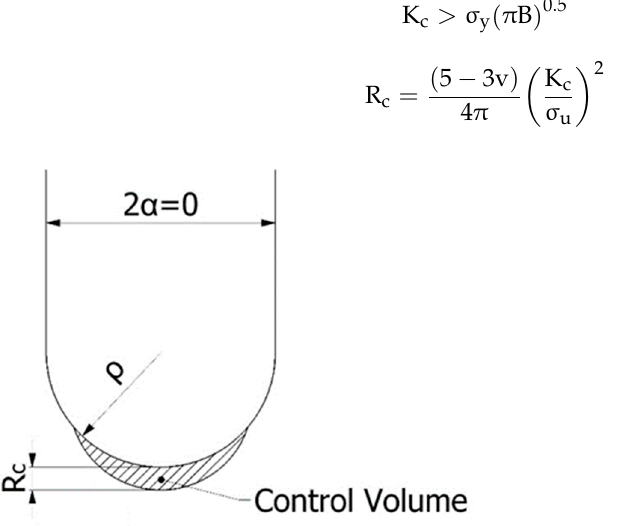
Figure 1. Control volume (area) for U-notch (2 α = 0) under mode I